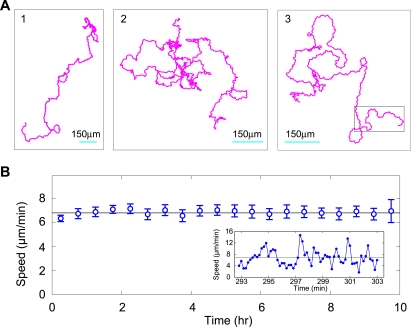
Cell trajectories and speeds.(A) Three typical 10 hr cell trajectories. Boxed regime, see Fig. 5 caption. (B) Cells do not slow down over the ten-hour observation time, so we can think of them as being in a stationary (time-independent) state. However, on the time-scale of minutes the speeds do show fluctuations around their average, time-independent values (see insert). The error bars were obtained by first using a 30 min window to average each of twelve trajectories, and then, for each 30 min average, calculating the standard error of the twelve averages.